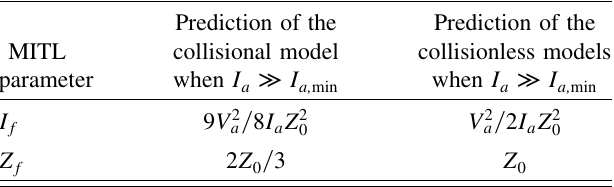
TABLE I. Theoretical expressions for the electron-flow cur- and flow impedance Z of a steady-state 1D planar MITL rent I f f (cid:9) I in the well-insulated limit (i.e., when I ). The colli- a a; min sional predictions are given by Eqs. (70) and (71); the collision- less predictions by Eqs. (84) and (85). The collisional predictions & 40 (cid:1) ; are also valid to first order for coaxial MITLs when Z 0 the collisionless predictions are valid for coaxial MITLs with arbitrary impedance. We expect that experimentally observed and Z will fall between the idealized collisional and values of I f f collisionless